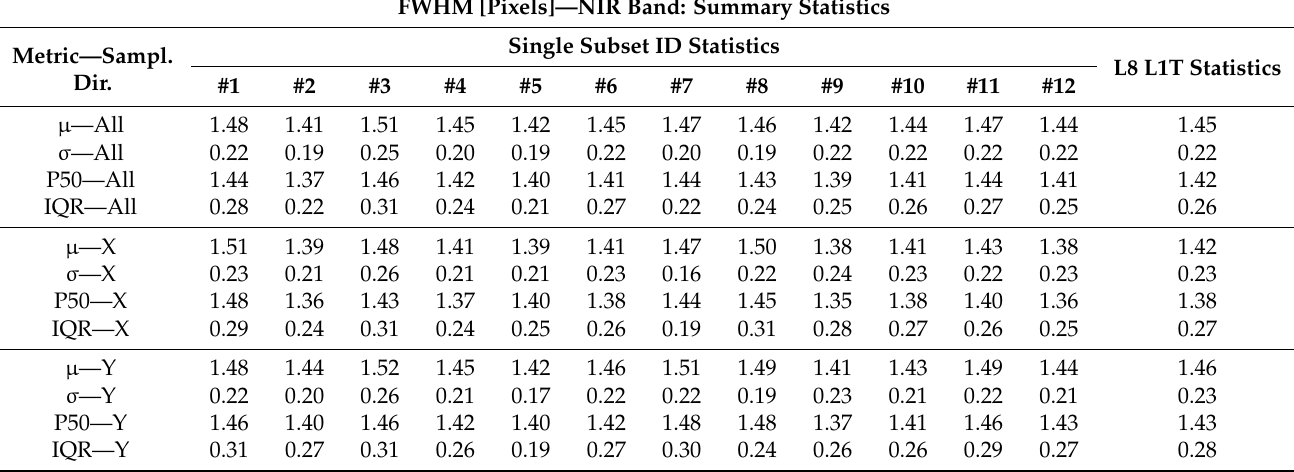
Table 7. SaSbEM validation results for the NIR